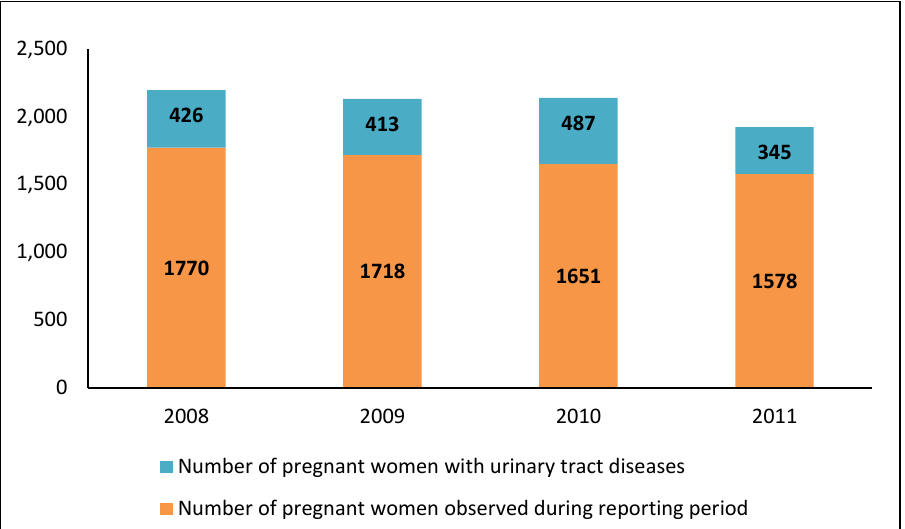
Figure 1: Number of diagnosed urinary tract diseases among pregnant women from the Urinary System Diseases at CP5 prenatal clinic of Almaty from 2008 to